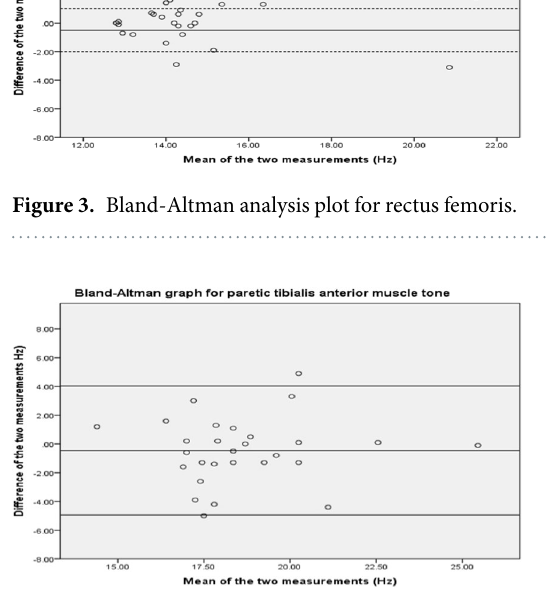
Figure 4. Bland-Altman analysis plot for tibialis